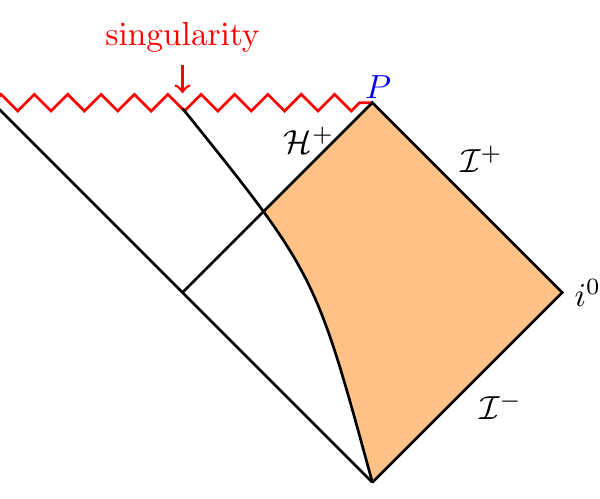
Figure 1. Space-time diagram for the collapsing black hole. The shaded region is the exterior of a collapsing star, and the r = 0 line at the top of the diagram is the singularity. H + denotes the event horizon. P is the future time, such as